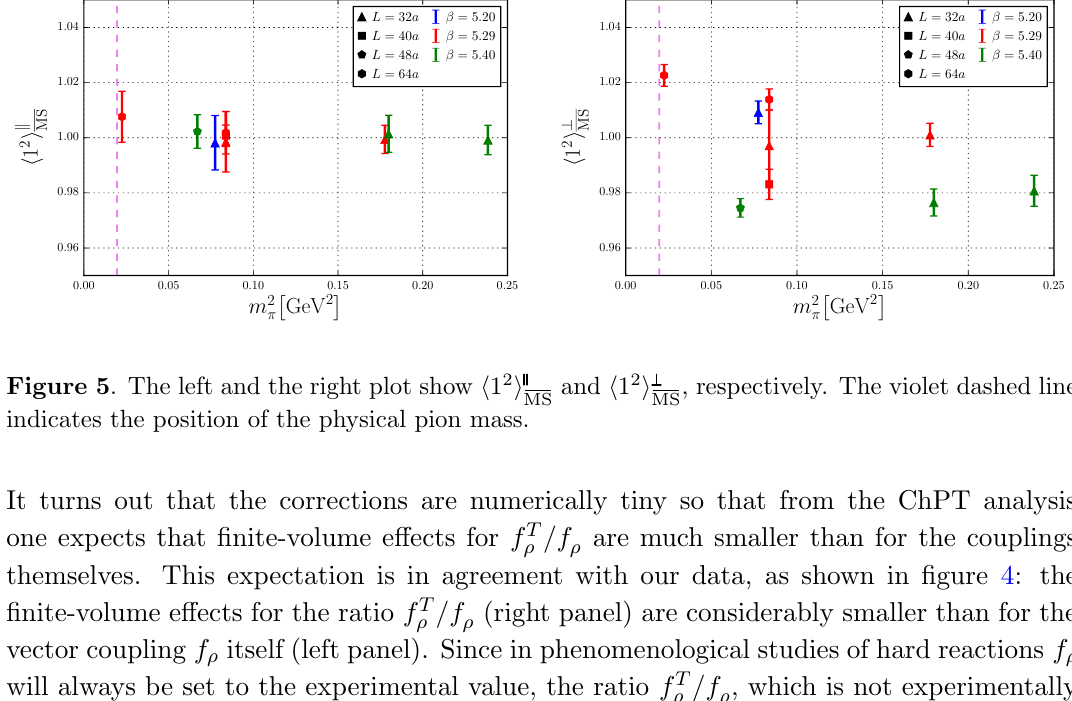
T =f (right panel) at (cid:12) = 5 : 29, (cid:20) = 0 : 13632. (cid:26) (cid:26)